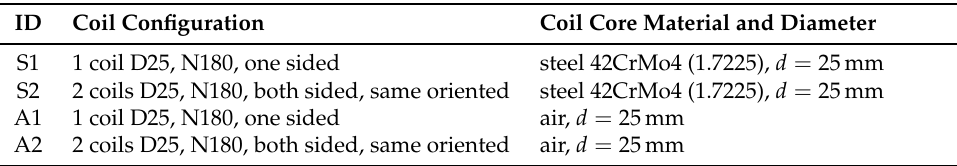
Table 6. Experimental configurations and parameters for measuring the residual magnetic flux density of the disc.